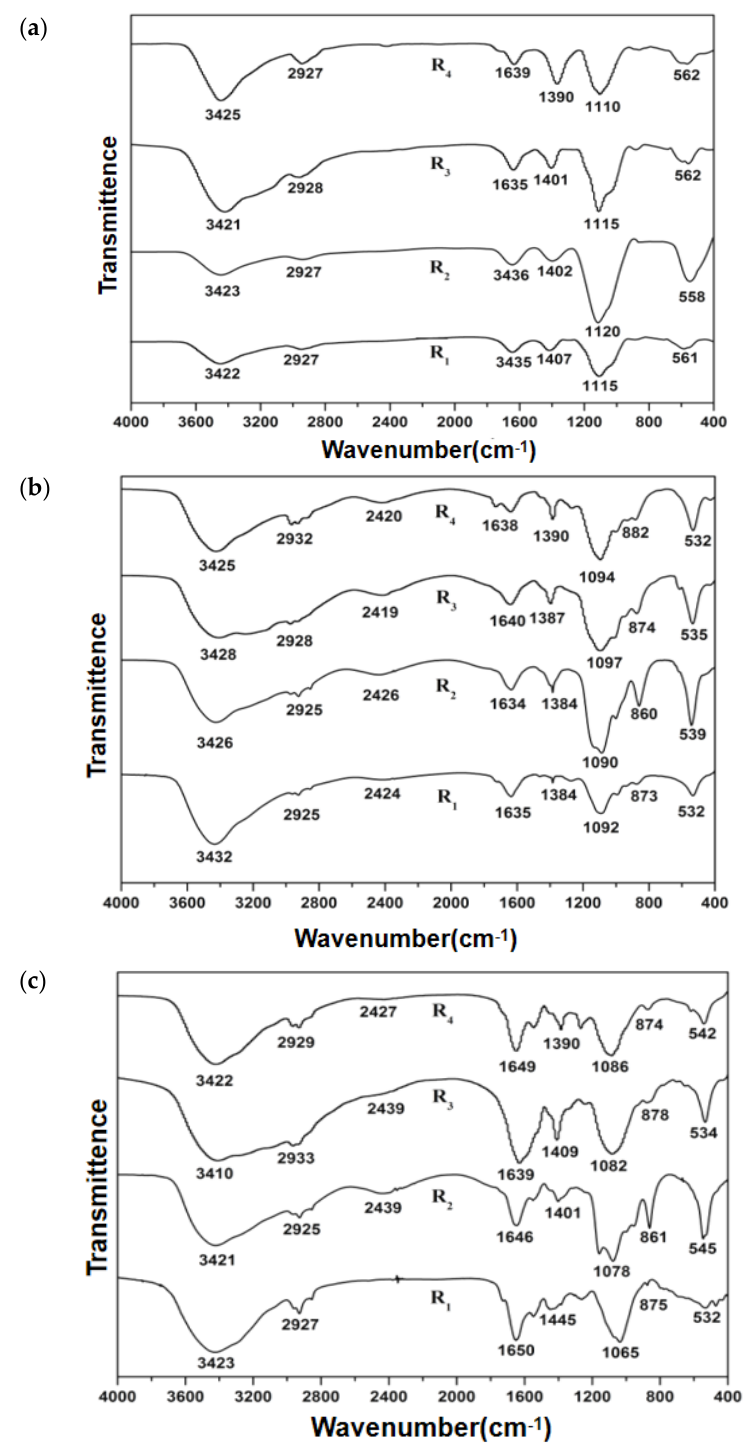
Figure 6. FTIR spectra of EPSs under four scenarios (R1–R4): ( a ) S-EPS; ( b ) LB-EPS; ( c ) TB-EPS. According to Figure 7, TB-EPSs contained more EPSs than S-EPSs and LB-EPSs